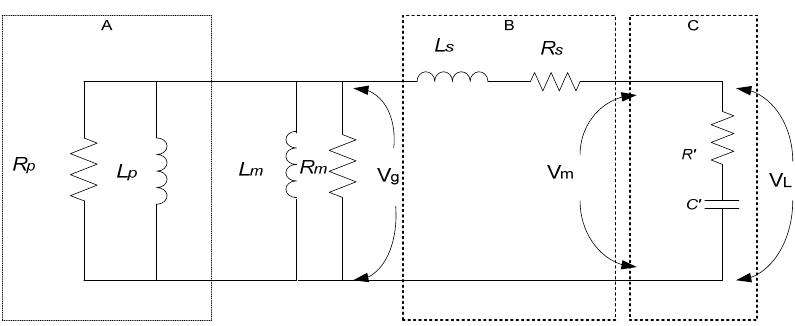
Figure 2. Simplified load side circuit.